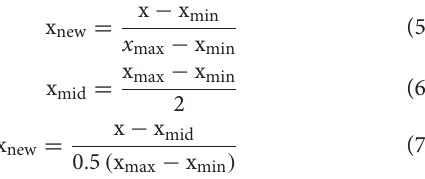
FIGURE 5 | The function curve of the sum of